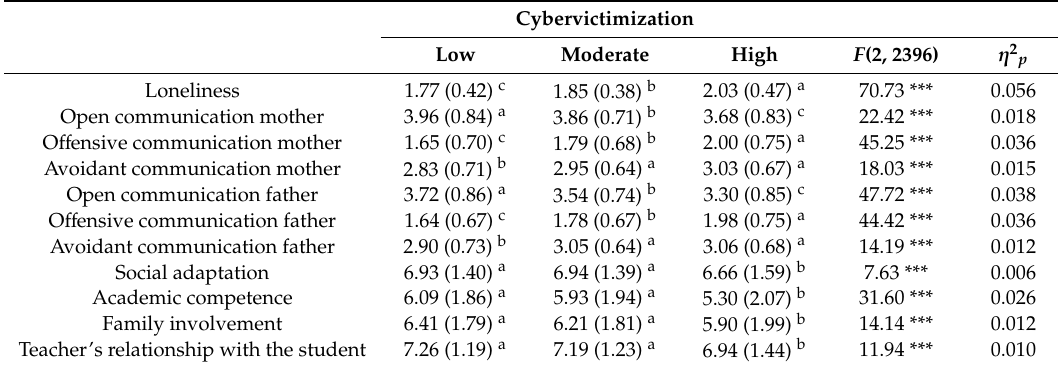
Table 3. Means, standard deviations (SD), and ANOVA results between cybervictimization, loneliness, family communication, and school adjustment.